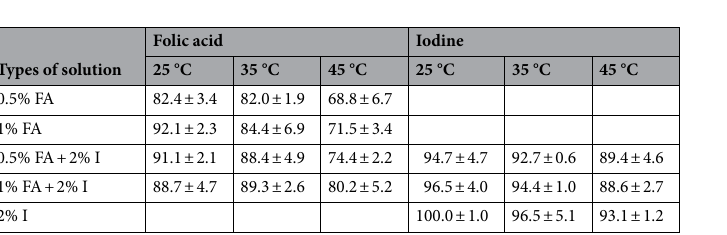
Table 2. Stability of folic acid and iodine in the optimized spray solution. FA = folic acid, I = iodine; the pH of the solutions were adjusted to pH